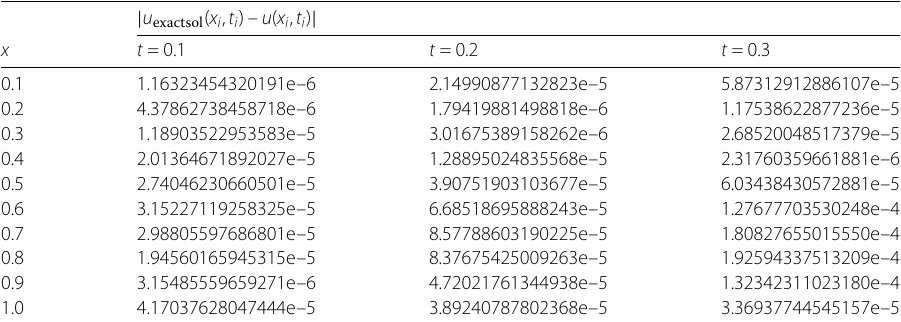
Table 2 Comparison of maximum absolute errors acquired using the GWGM for β = 3/2, α = 1 of Example 1 with given initial and boundary conditions